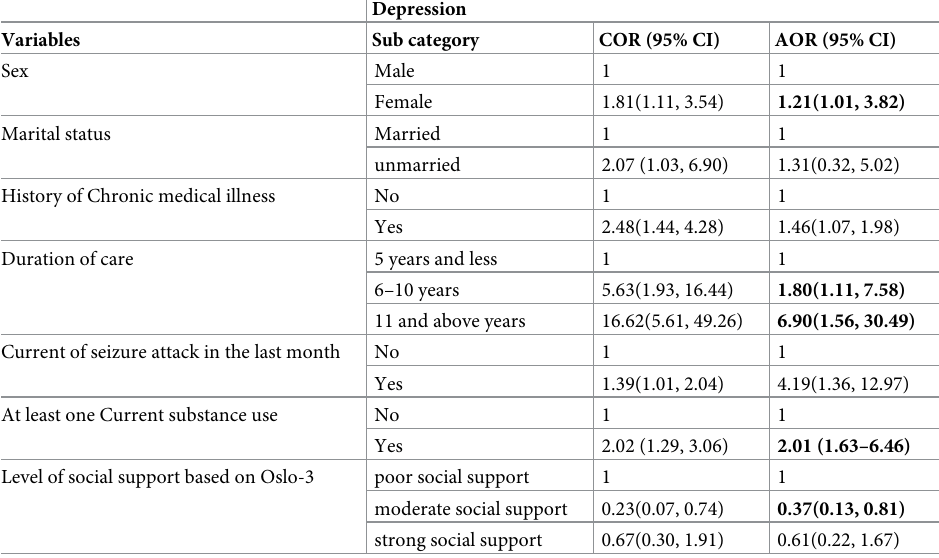
Table 3. Bivariate and multivariate analysis of factors associated with depression among caregivers of children and adolescents with epilepsy attending follow up visits in the three hospitals (n =